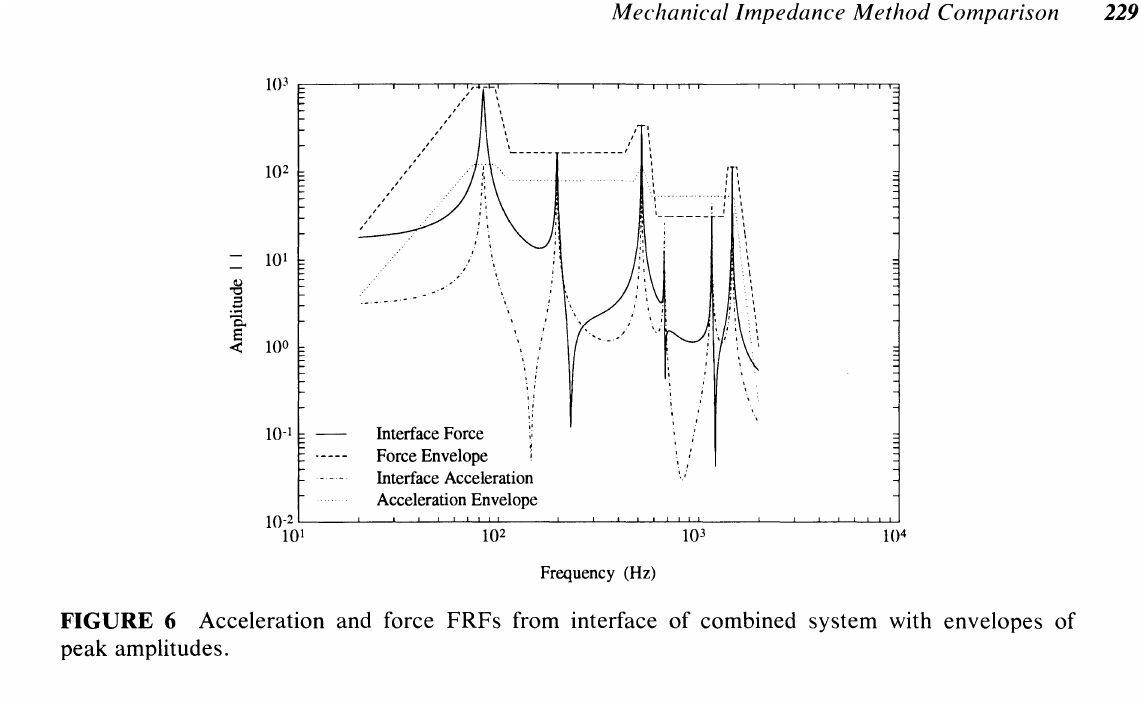
FIGURE 6 Acceleration and force FRFs from interface of combined system with envelopes of peak amplitudes.